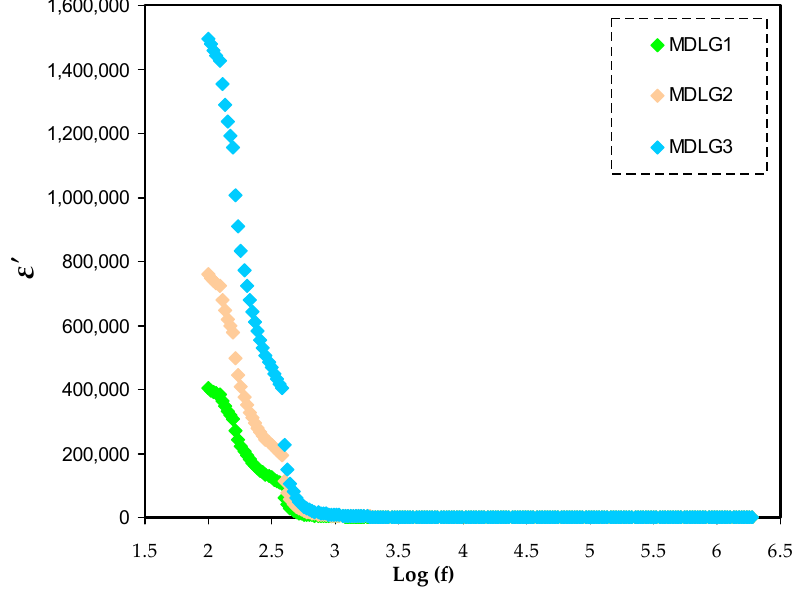
Figure 4. ε ′ spectra versus frequency for MC:Dex:LiClO 4 :Glycerol electrolytes.